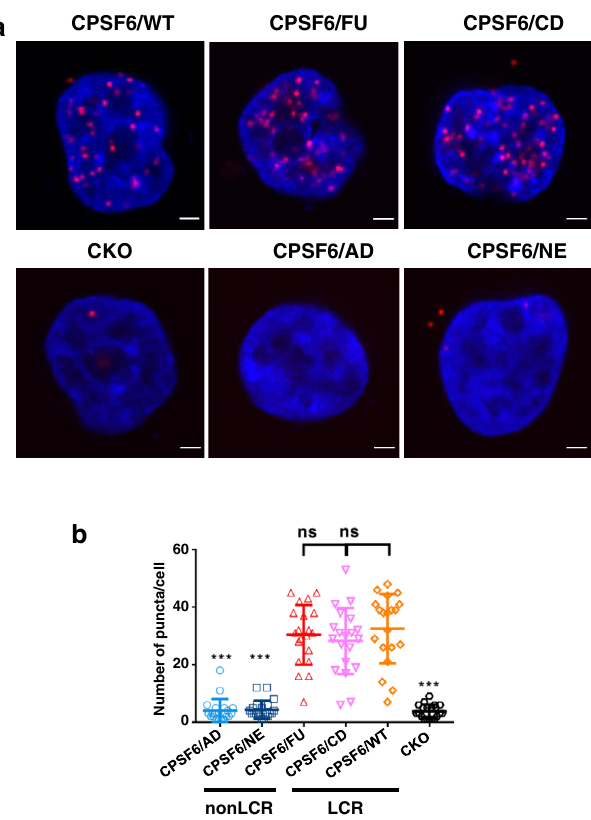
Fig. 2 | LCR sequences are critical for CPSF6 interaction with HIV-1 cores in infected cells. a PLAs showing associationof HA-tagged ectopicallyexpressedWT and chimeric CPSF6 proteins with incoming HIV-1 particles in HEK293T CKO cells. The cells were fi xed at 6 hpi and PLAs were performed using anti-HA (ab236632, Abcam) and anti-HIV-1 CA speci fi c antibodies (ARP-4121, NIH AIDS Reagent Pro- gram). The representative images show PLA puncta (red) and nuclei stained with DAPI (blue). Scale bar is 2 μ m. b Quantitative results showing numbers of PLA puncta per cell by analyzing twenty- fi ve cells for each sample. The averaged data (+/ − SD) from threeindependent experiments areshown.Statisticalsigni fi canceof comparison of WT versus the chimeric CPSF6 proteins was determined by Stu- dent ’ s two-sample, two-tailed t -test. CPSF6/AD: p =3.1E-12; CPSF6/NE: p =2.4e-12; CPSF6/FU: p =0.54; CPSF6/CD: p =0.26; CKO: p =8.8E-13. P >0.05 was considered not signi fi cant (ns) and p <0.0001 was considered highly signi fi cant (***). Source data are provided as a Source Data fi le. AD ADD2, NE NEURM, FU FUS, CD CDK19, WT wild-type CPSF6, CKO CPSF6 knock-out, LCR low complexity